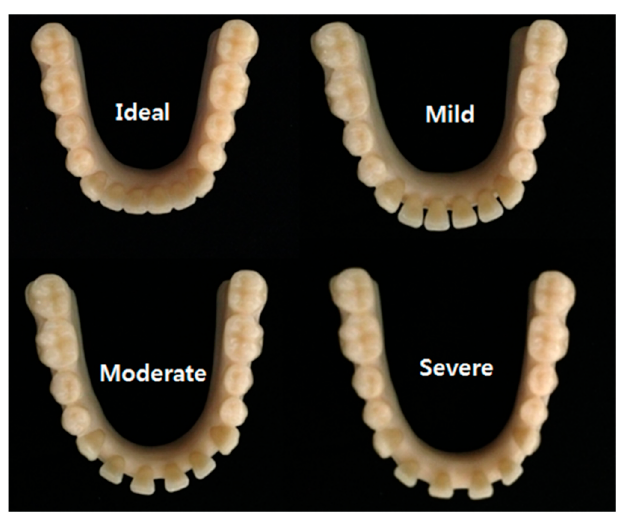
Figure 1. The experimental models with different interdental spaces in the anterior dentition. Ideal has no spacing (0 mm); Mild has 1 mm spacing; Moderate has 3 mm spacing; Severe has 5 mm spacing.